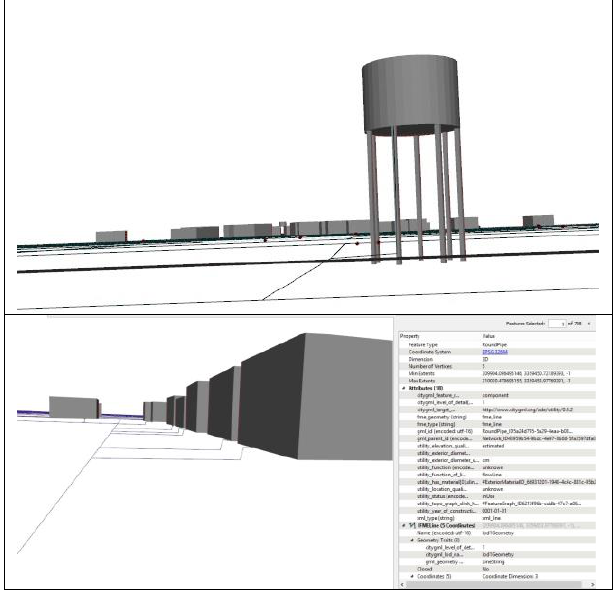
Figure 5. Topographical model of water supply